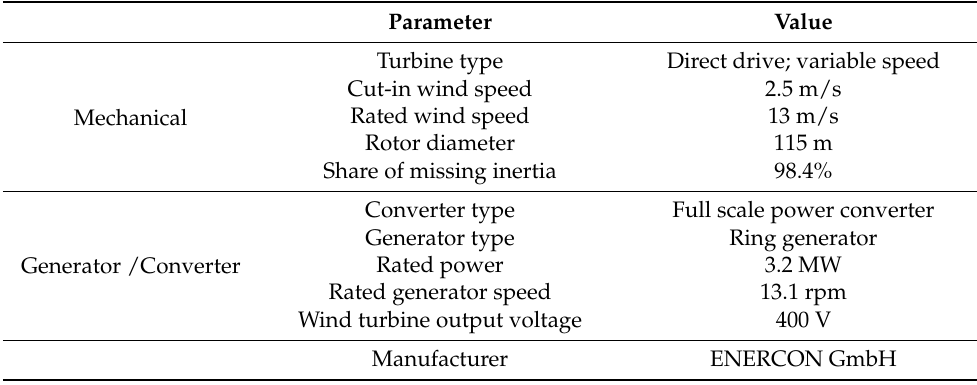
Table 3. DUT parameters based on construction